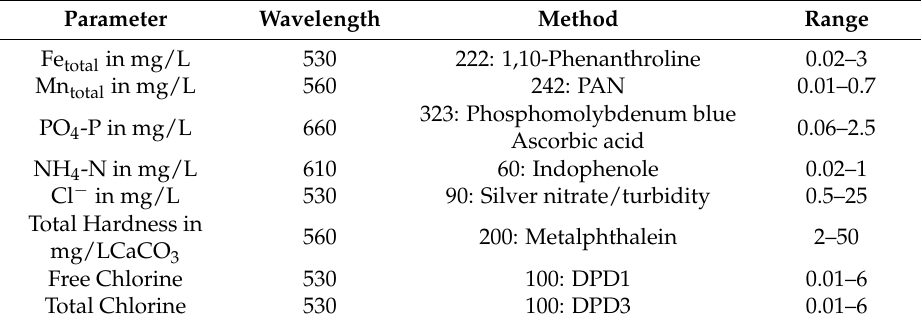
Table 5. Parameters and methods used for analysis with the AL400